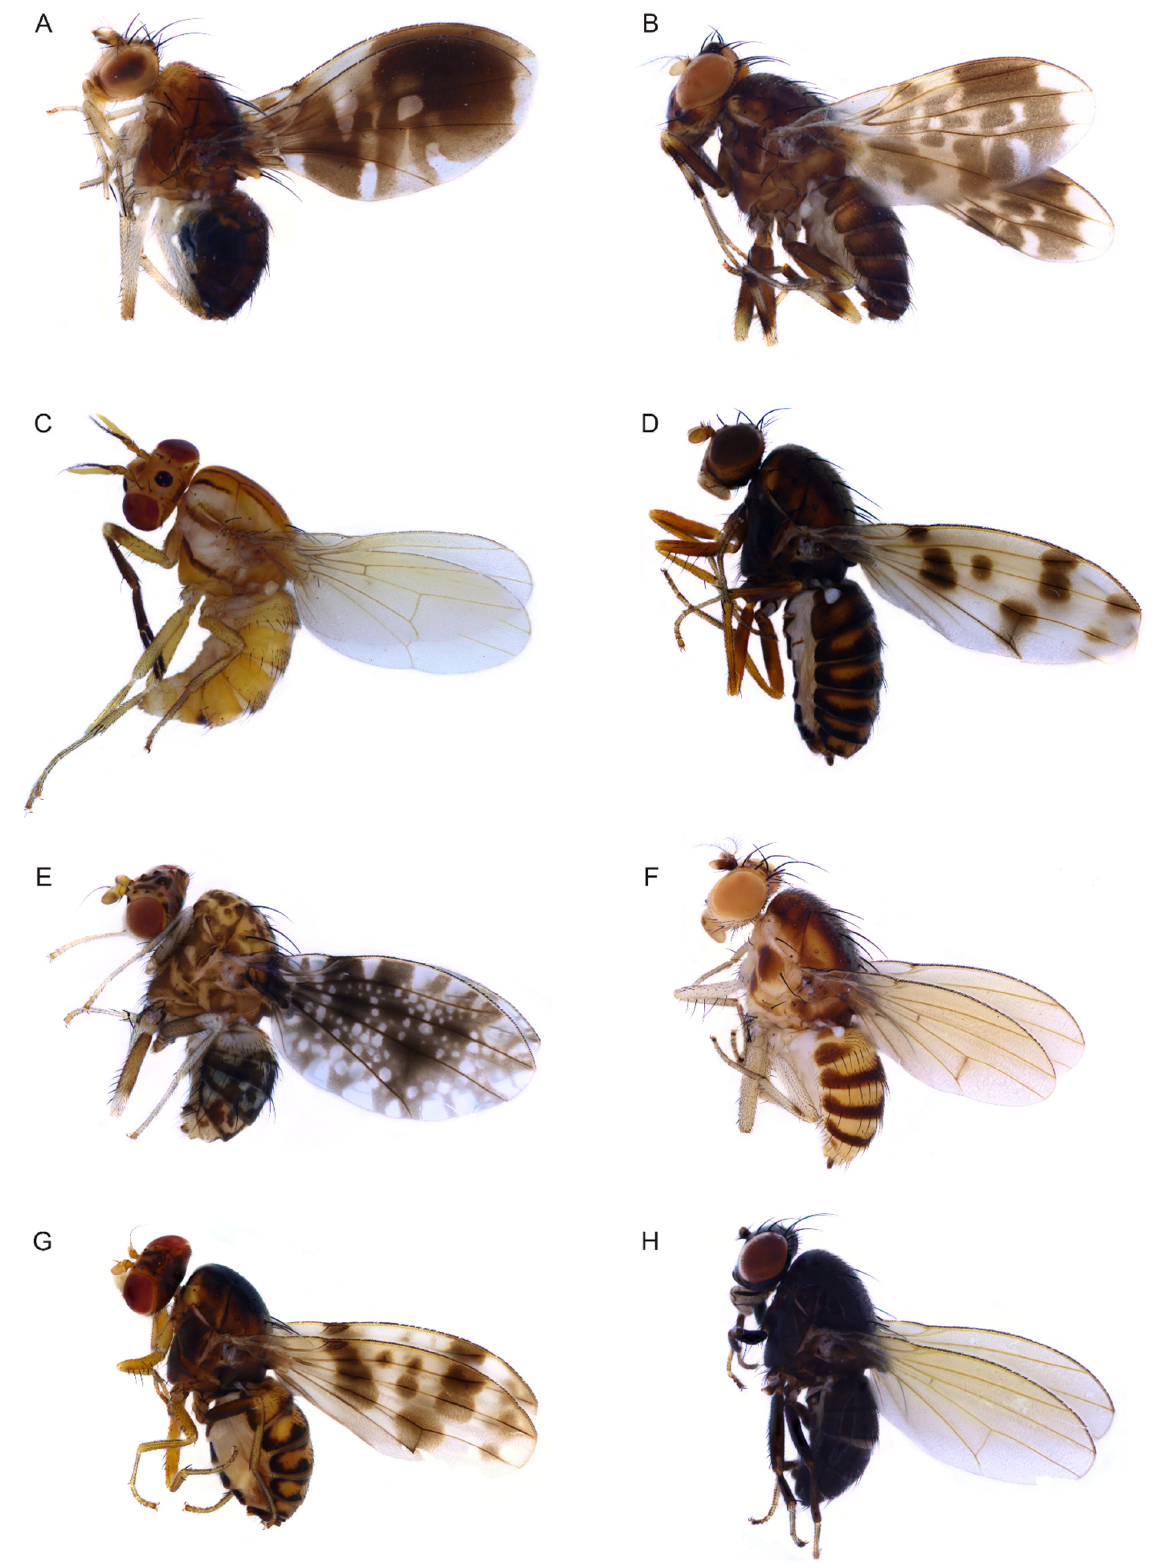
Figure 1. Adults of species of Lauxaniidae. ( A ): Noonamyia umbrellata ; ( B ): Cestrotus liui ; ( C ): Pachycerina decemlineata ; ( D ): Homoneura ( Euhomoneura ) shatalkini ; ( E ): Homoneura ( Homoneura ) picta ; ( F ): Homoneura ( Homoneura ) flavida ; ( G ): Homoneura ( Homoneura ) dorsacerba ; ( H ): Homoneura ( Homoneura ) noticomata .